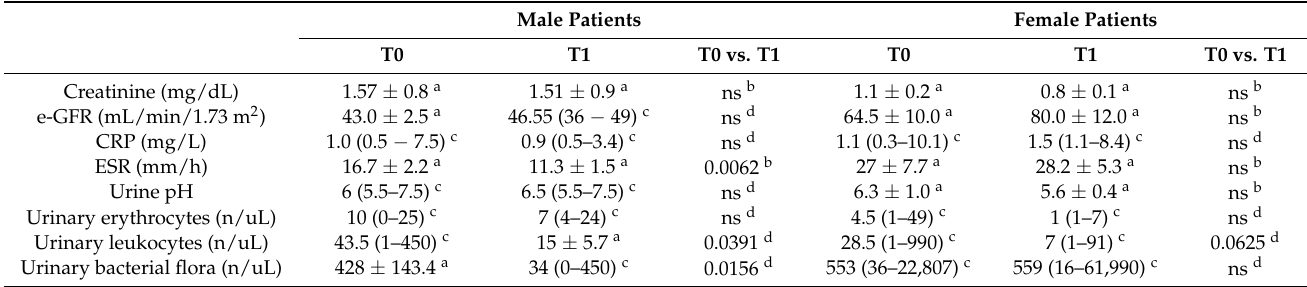
Table 3. Laboratory parameters of two subgroups of OFS patients.